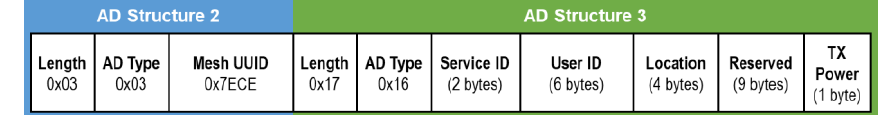
Table 1. Hardware and software used in our prototype system.